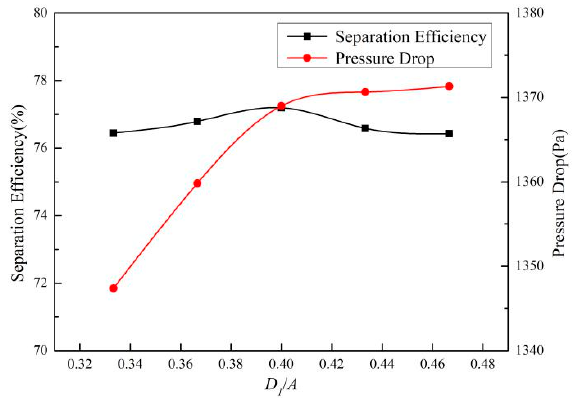
Figure 9. Effect of the vortex finder diameter ( D 1 /A ) on efficiency and pressure drop. Figure 9. E ff ect of the vortex finder diameter ( D 1 / A ) on e ffi ciency and pressure drop.